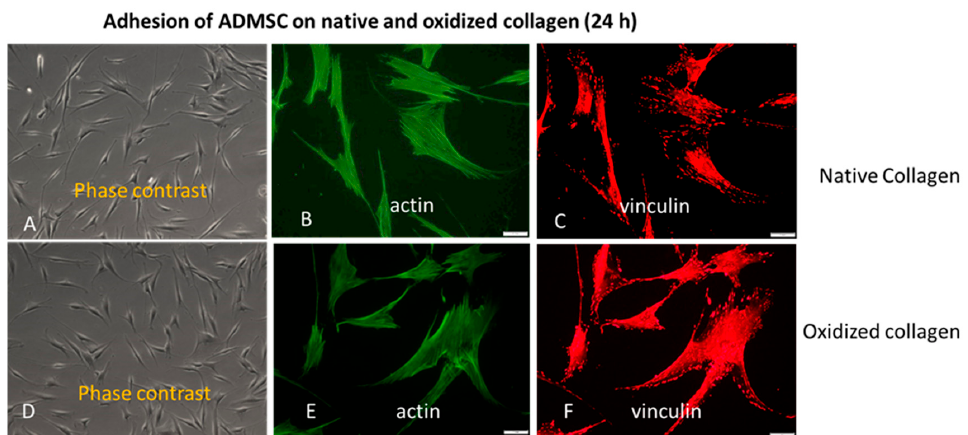
Figure 2. The approximately equal cell spreading ( A , D ) corroborates with the similar actin cytoskel- eton development ( B , E ) and focal adhesions formation ( C , F ) at the 24th h of ADMSC adhesion to native (upper row) and oxidized collagen (bottom row). Bar 20 μ m.